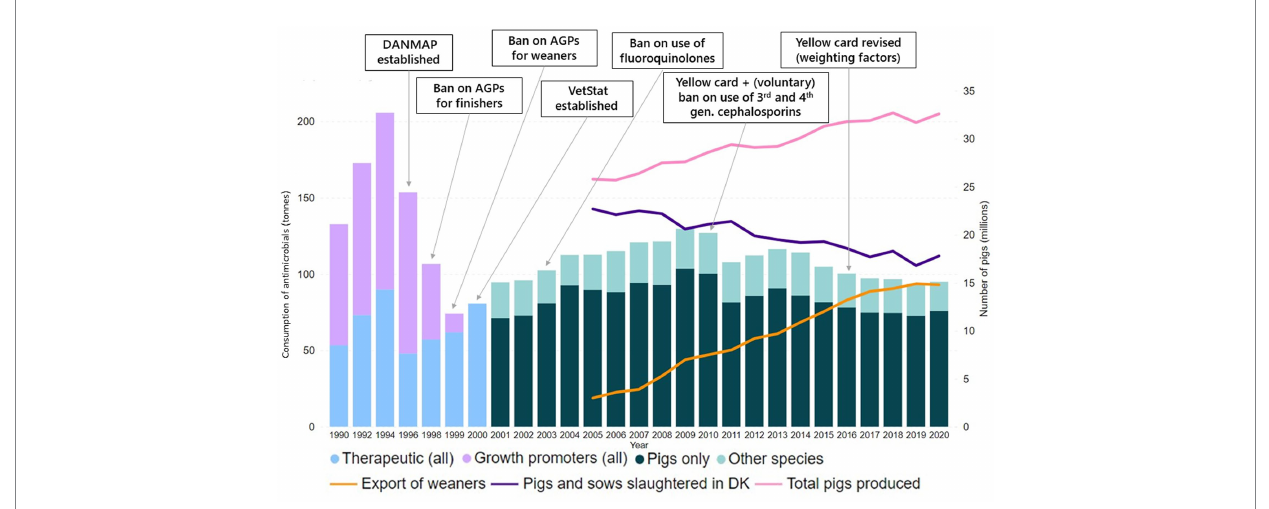
FIGURE 1 Total amount of AMU in Danish livestock from 1990 to 2000 and in the pig sector from 2001, total number of pigs produced in Denmark since 2005, divided into weaners exported and pigs and sows slaughtered domestically, and risk mitigating initiatives. AGP, Antimicrobial growth promoters; DK, Denmark; DANMAP, Danish Integrated Antimicrobial Resistance Monitoring and Research